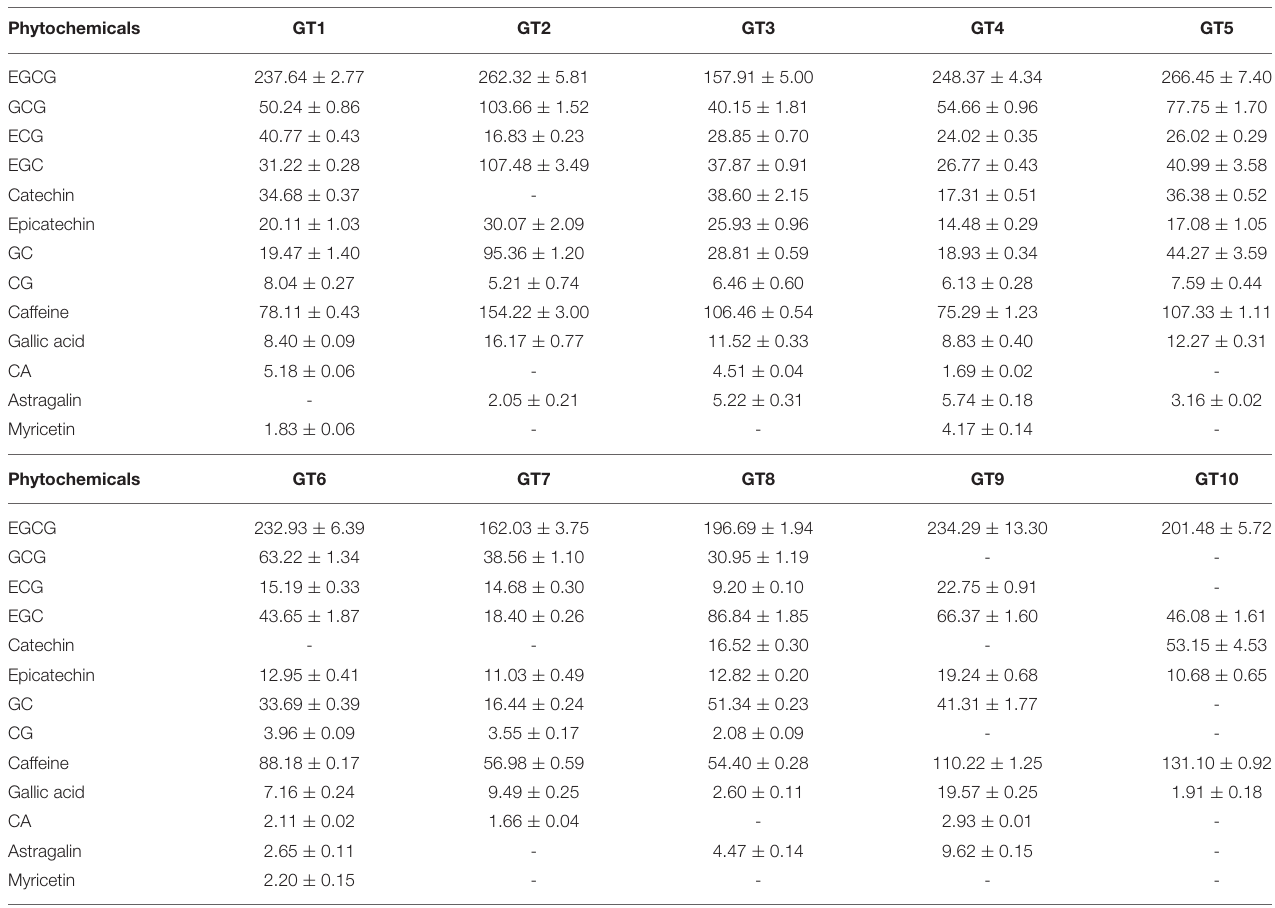
Myricetin 2.20 ± 0.15 - - -